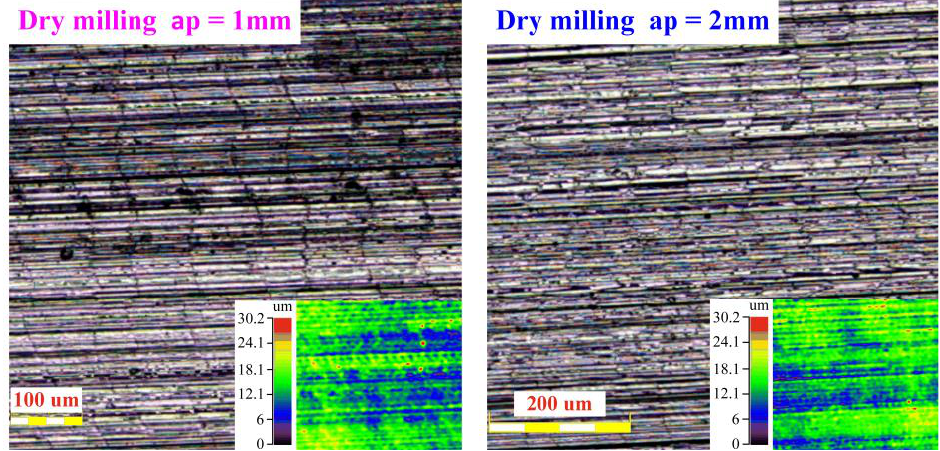
Figure 11. The surface topography of the machined workpiece at different axial cutting depths.